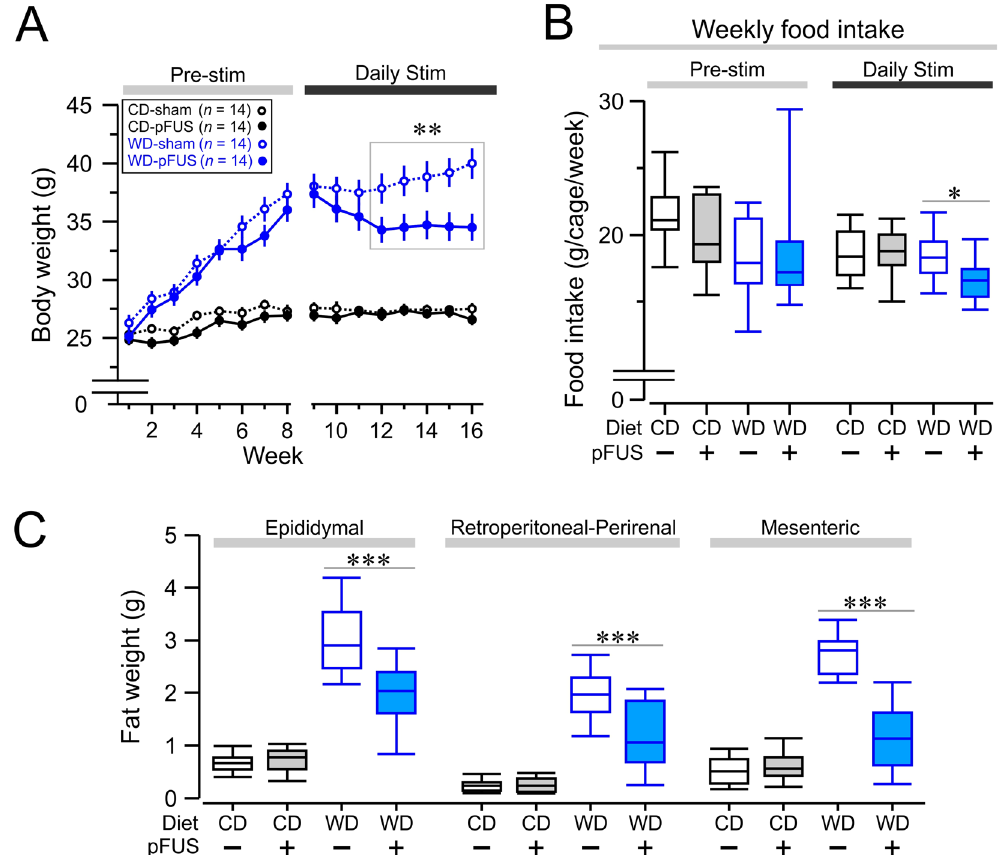
Figure 2. Hepatic pFUS reduces body weight gain, food intake, and abdominal adiposity in Western diet-fed mice. ( A ) Body weight as a function of time under the indicated conditions. Mice were given either Western diet (WD, blue plots) or control diet (CD, black plots) for a period of 8 weeks. On week 9, mice either received daily peripheral focused ultrasound stimulation (pFUS; closed circles, solid line) or sham stimulation (open circles, dashed line) for the remainder of the experiment. Starting at week 12, the Western diet–pFUS group (closed blue circles) had significantly attenuated body weight in comparison to Western diet–sham controls (** P < 0.01, two-way RMANOVA, week 12 WD–pFUS vs WD–sham). ( B ) Western diet-fed mice have reduced food intake after ultrasound stimulation. The food intake of the mice was monitored and calculated per cage per week. No significant difference was found among any of the groups in the pre-stimulation period ( P > 0.05, one- way ANOVA, weeks 1–8). Post-stimulation food intake was monitored, and the food intake of the Western diet–pFUS group was found to be significantly reduced (* P < 0.05, two-way ANOVA, WD–pFUS vs WD– sham). C. Hepatic pFUS reduces abdominal adiposity. Fat weight (g) was measured on three visceral fat pads (Epidydimal, Retroperitoneal/Perirenal, and Mesenteric) extracted postmortem. The Western diet–pFUS group had significantly lower fat weight in the three fat pads compared to the Western diet–sham group (Epidydimal & Mesenteric, *** P < 0.001, two-way ANOVA; Retroperitoneal/Peririenal, **** P < 0.0001, two-way